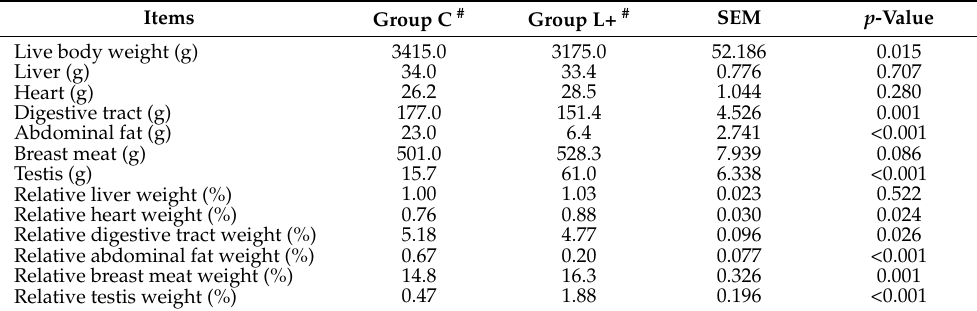
Table 2. Effects of the nocturnal 1-h lighting on the organ weights of male mule ducks. Items